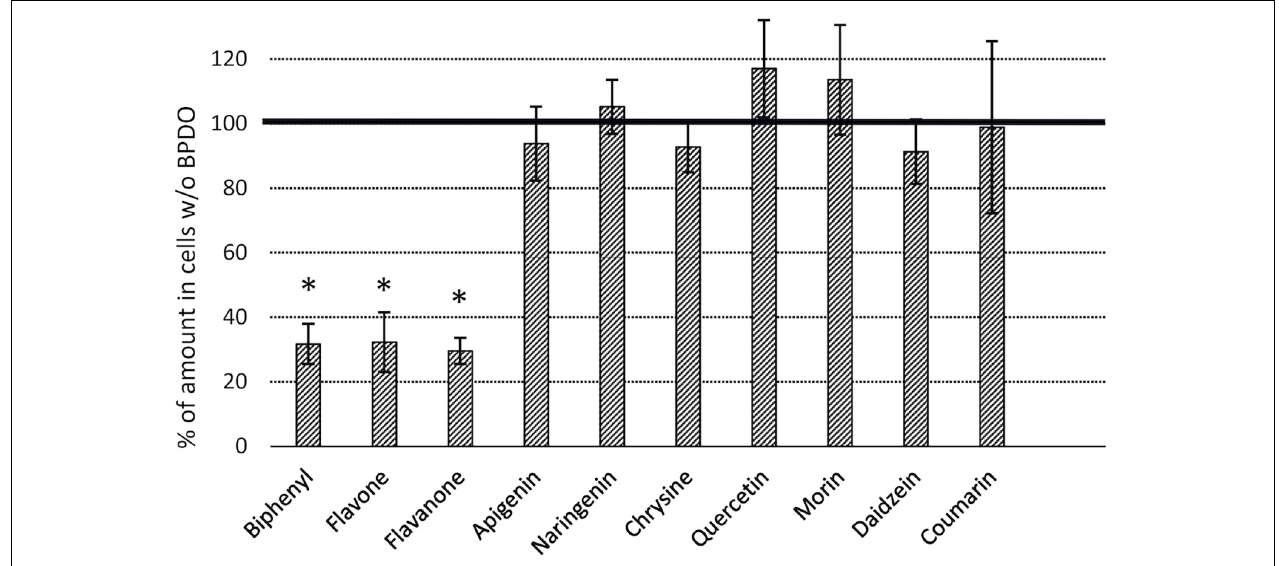
FIGURE 5 | Depletion of flavonoids by E. coli cells expressing BPDO_AVS. The depletion rates were determined after the resting cell assay using IPTG-induced cells bearing both pQE31-bphAE_AVS and pYH31-bphFGBC_LB400 incubated with a 25 µ M substrate for 24 h. The BPDO activity is shown as % of a SPM amount in control microcosms bearing cells lacking BPDO_AVS. ( ∗ ) statistically significant difference from the corresponding control ( p value < 0.05). Error bars represent standard deviation ( n = 4).